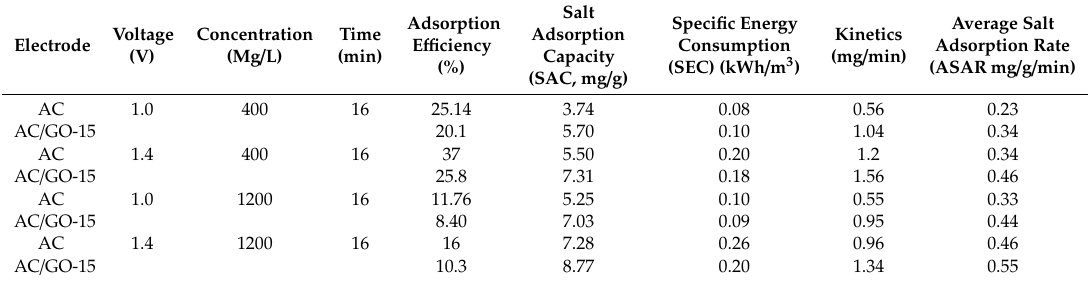
Table 5. CDI performance matrices of AC and AC / GO-15 electrodes at all operating